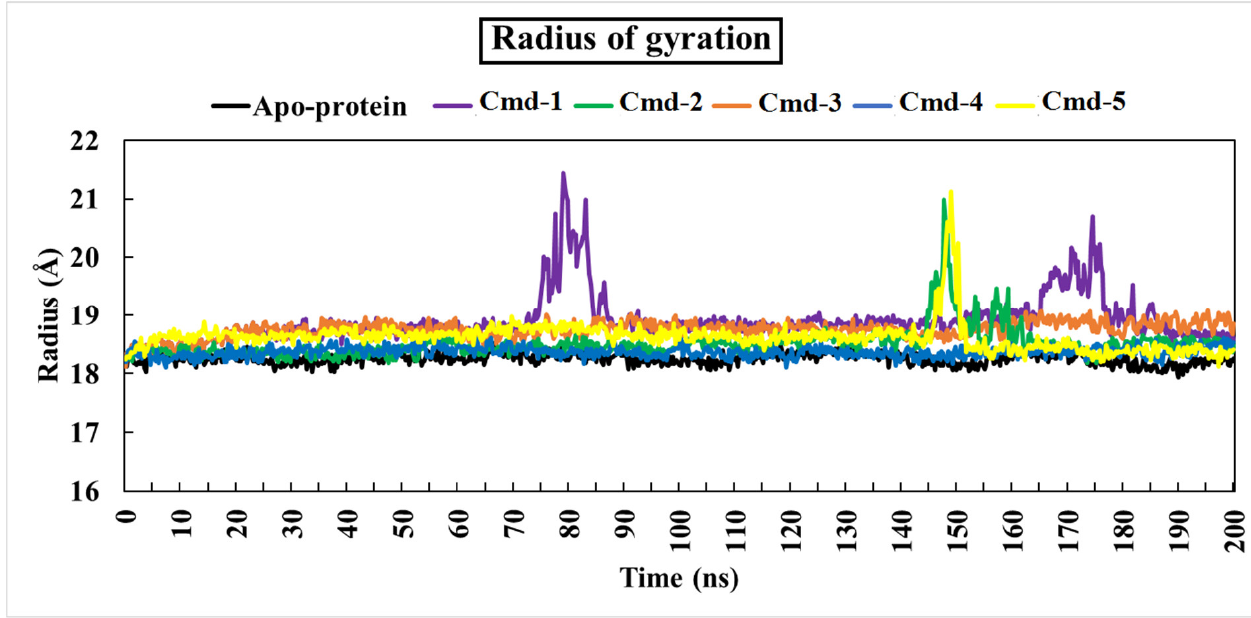
Figure 8. Radius of gyration (Rg) plot of apoprotein structure and five identified complexes through 200 ns MD simulations.